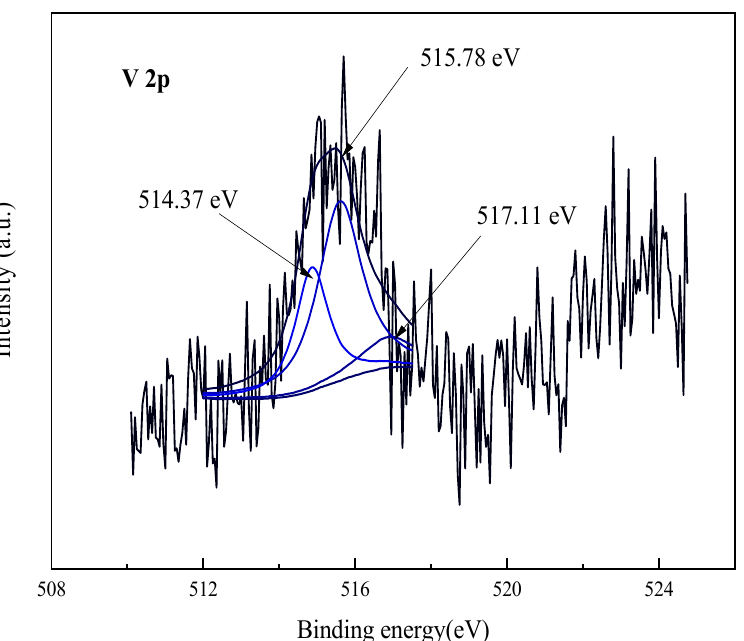
Figure 4. V 2p spectrum of deactivated denitration catalyst.